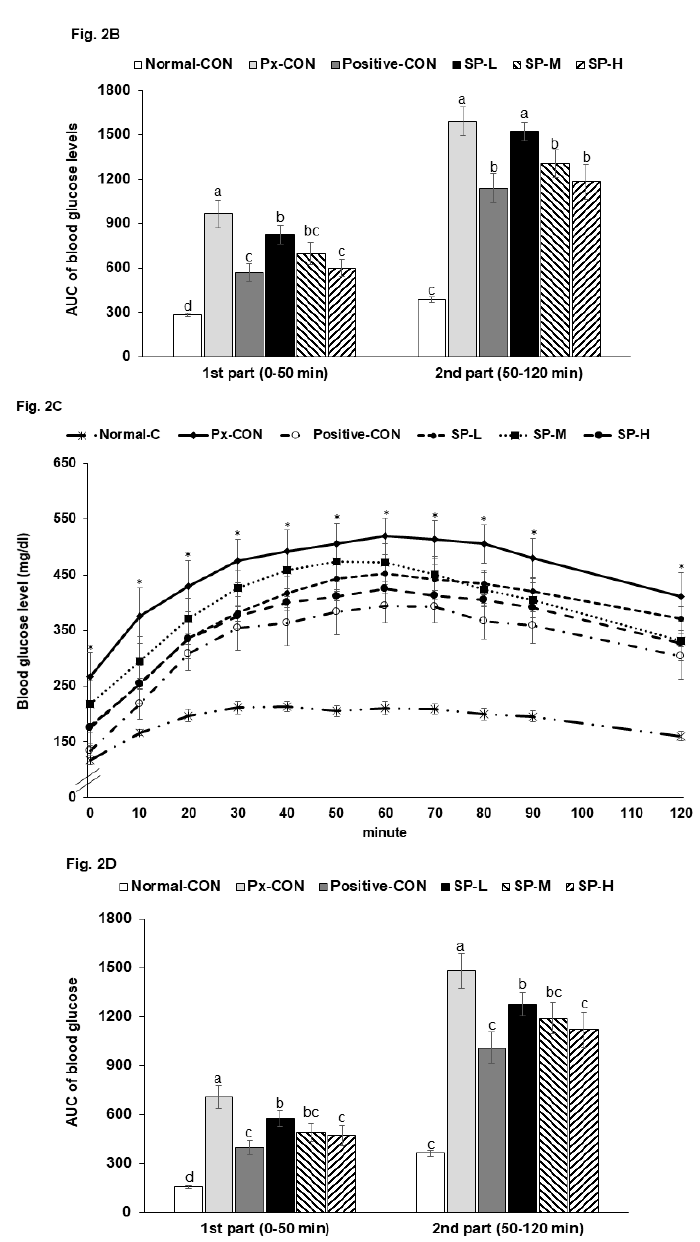
Figure 2. Serum glucose levels during oral glucose tolerance test (OGTT) and oral maltose tolerance test (OMTT) after a 16 h fast. ( A ). Changes in serum glucose concentrations after an oral challenge of 2 g glucose/kg. ( B ). Areas under the curve (AUC) for serum glucose during the first (0–40 min) and second phases (40–120 min) of OGTT. ( C ). Changes in serum glucose concentrations after an oral challenge with 2 g maltose/kg. ( D ). Areas under the curve (AUC) for serum glucose during the first (0–40 min) and second phases (40–120 min) of OMTT. Bars or dots and error bars represent means ± SDs ( n = 10). * indicates a significant intergroup difference ( p < 0.05). a,b,c Different letters on bars indicate significant differences ( p < 0.05).